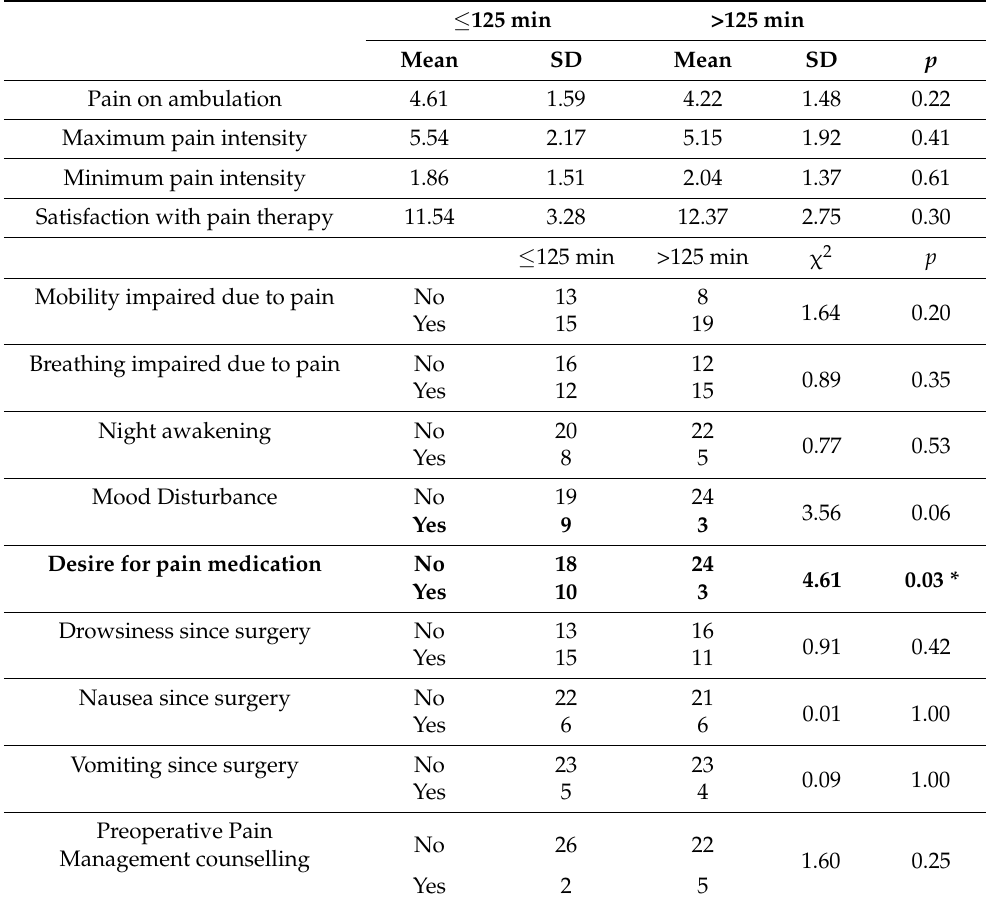
Table 4. Relation between outcome parameters and operation